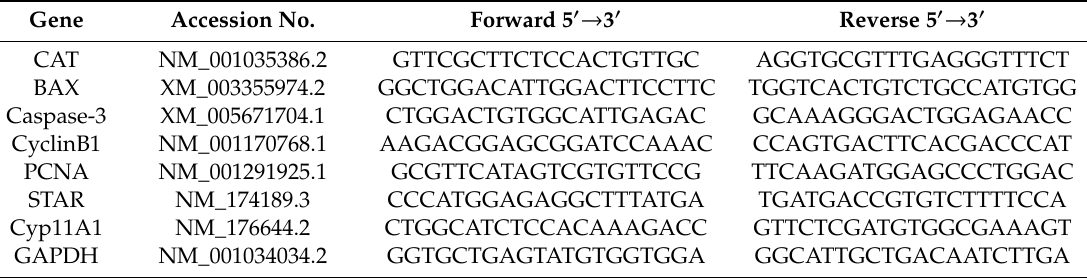
Table 1. List of gene primers used for